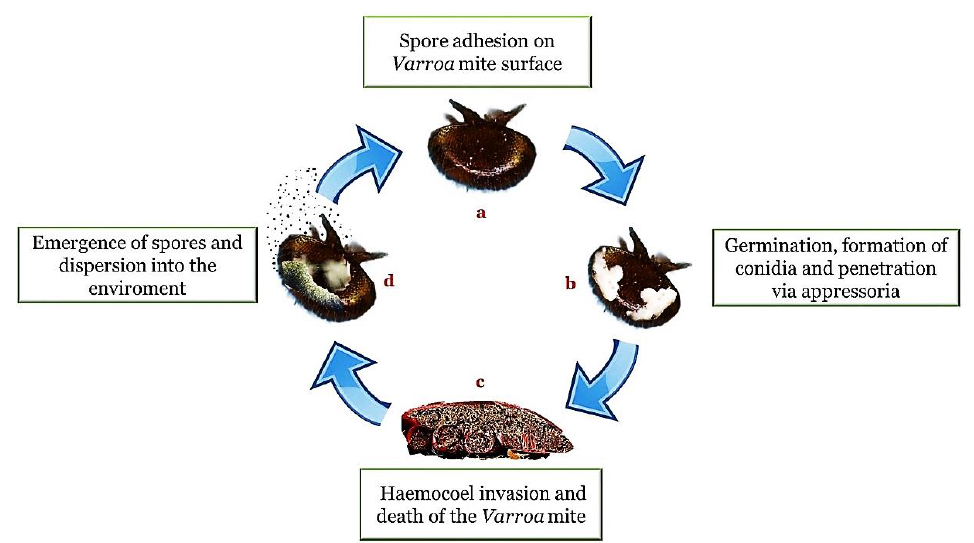
Figure 1. Entomopathogenic infection cycle (method of action). In presence of a suitable substrate and a favorable environment, the adhesion of the spores ( a ) is followed by germination, the formation of hyphae and structures such as the conidia and the appressorium ( b ). Once penetrated inside the body cavity (haemocoel), the fungi cause a depletion of nutrients and a destruction of the tissues until the death of the host ( c ). The cycle is completed with emergence on the surface of the body for the propagation of the infectious elements in the external environment ( d ).